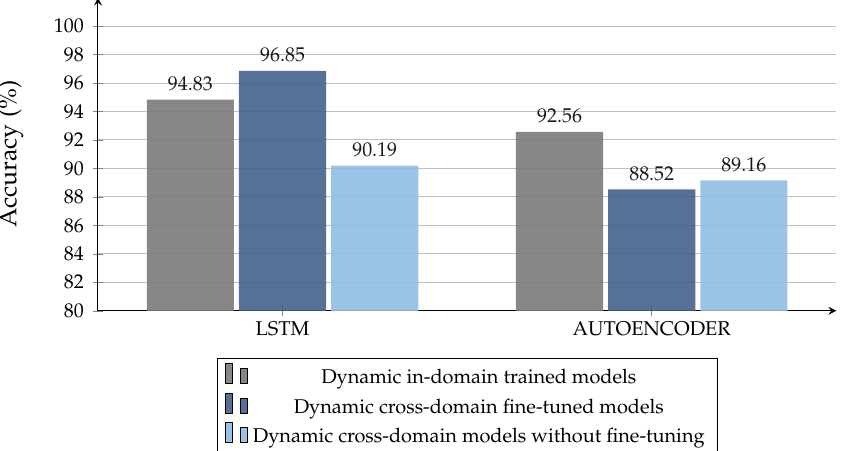
Figure 14. Comparison of best models trained on raw data ( 10% ) —Cross-Domain with fine-tuning